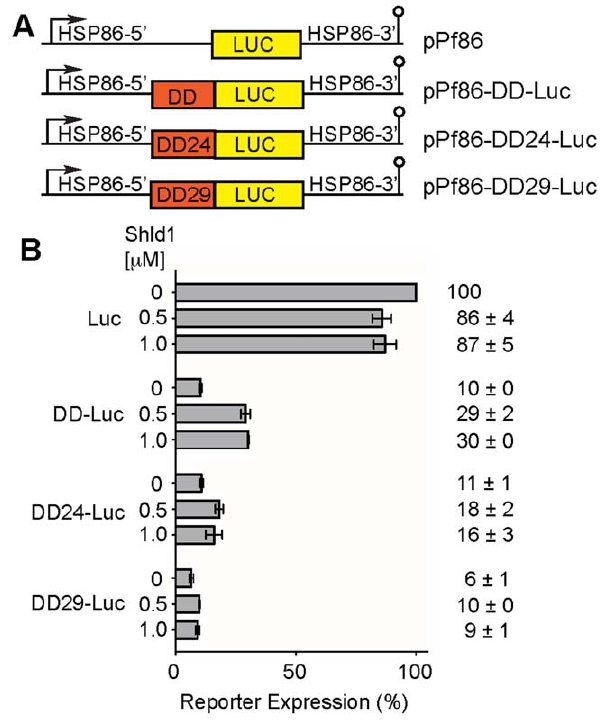
Figure 3. Regulation with N-terminal DD. (A) Maps of reporter plasmids tested. (B) Reporter expression of transiently transfected parasites. Parasite transfection and Shld-1 incubation was performed as indicated in Figure 2. Luciferase activity is represented relative to pPf86 kept without Shld-1. Results are the average of 3 experiments and the error bars show the standard deviation.